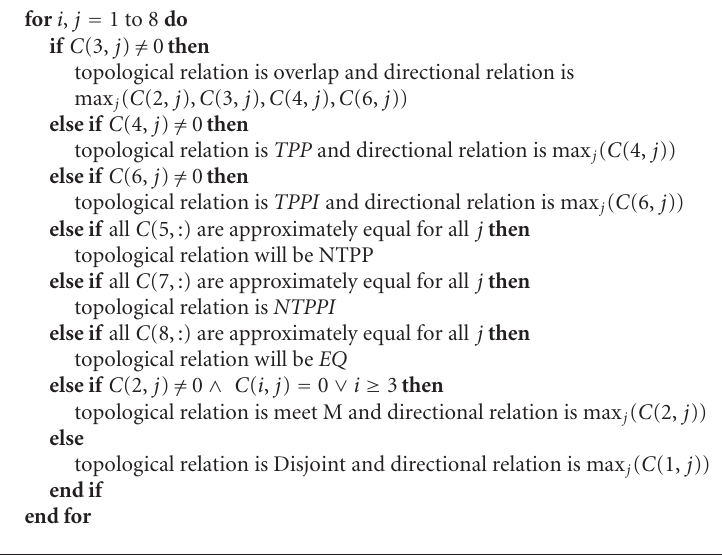
Algorithm 1: Algorithm for defuzzification of 2D fuzzy topological and directional relations.